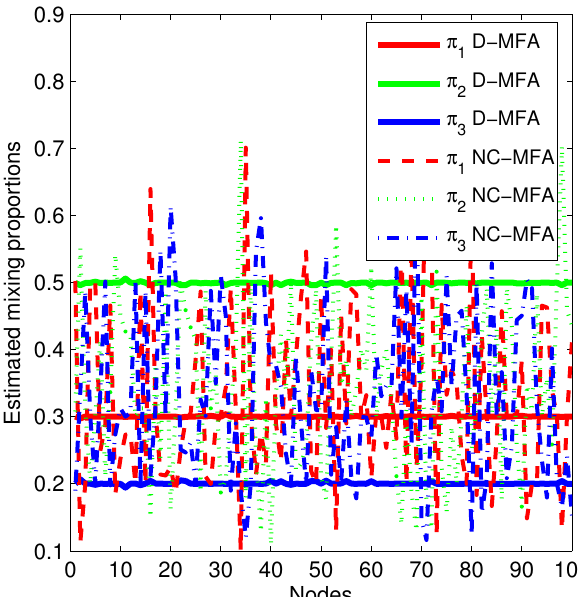
, π , π ) in the D-MFA and the NC-MFA 1 2 3